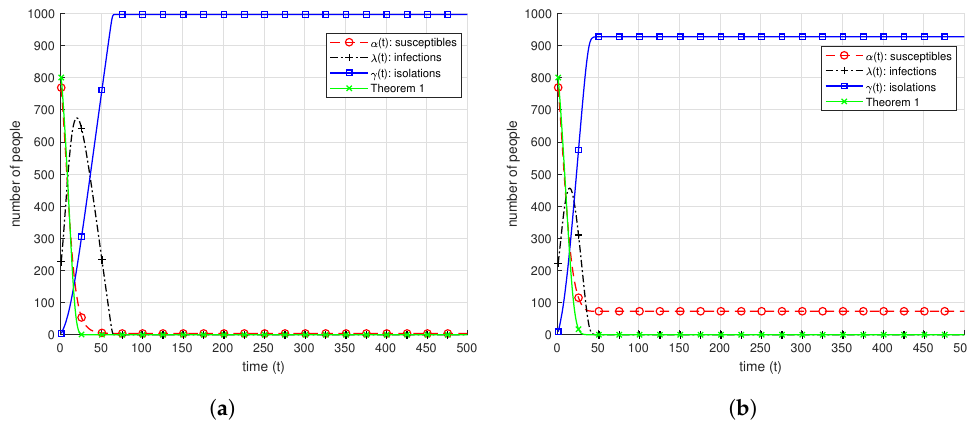
Figure 3. Average values of the random processes α ( t ) , λ ( t ) and γ ( t ) , with obtained theoretical approximations given in Theorem 1 when n = 1000, T = 40, q = 0.0002, p = 0.2, for ( a ) dynamic Dorfman type group testing algorithm, ( b ) dynamic individual testing